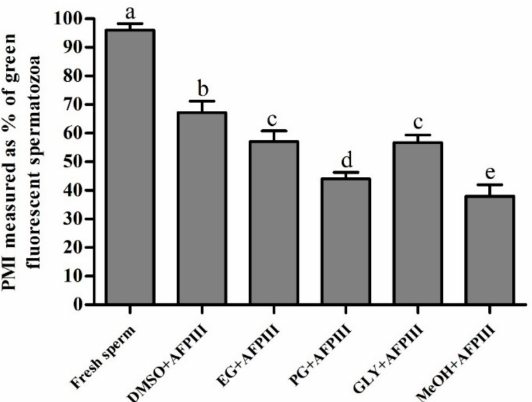
Figure 2. Plasma membrane integrity (PMI) (%) of post-thaw sperm of H. discus hannai . Significantly different levels ( p < 0.05) are denoted by different letters.